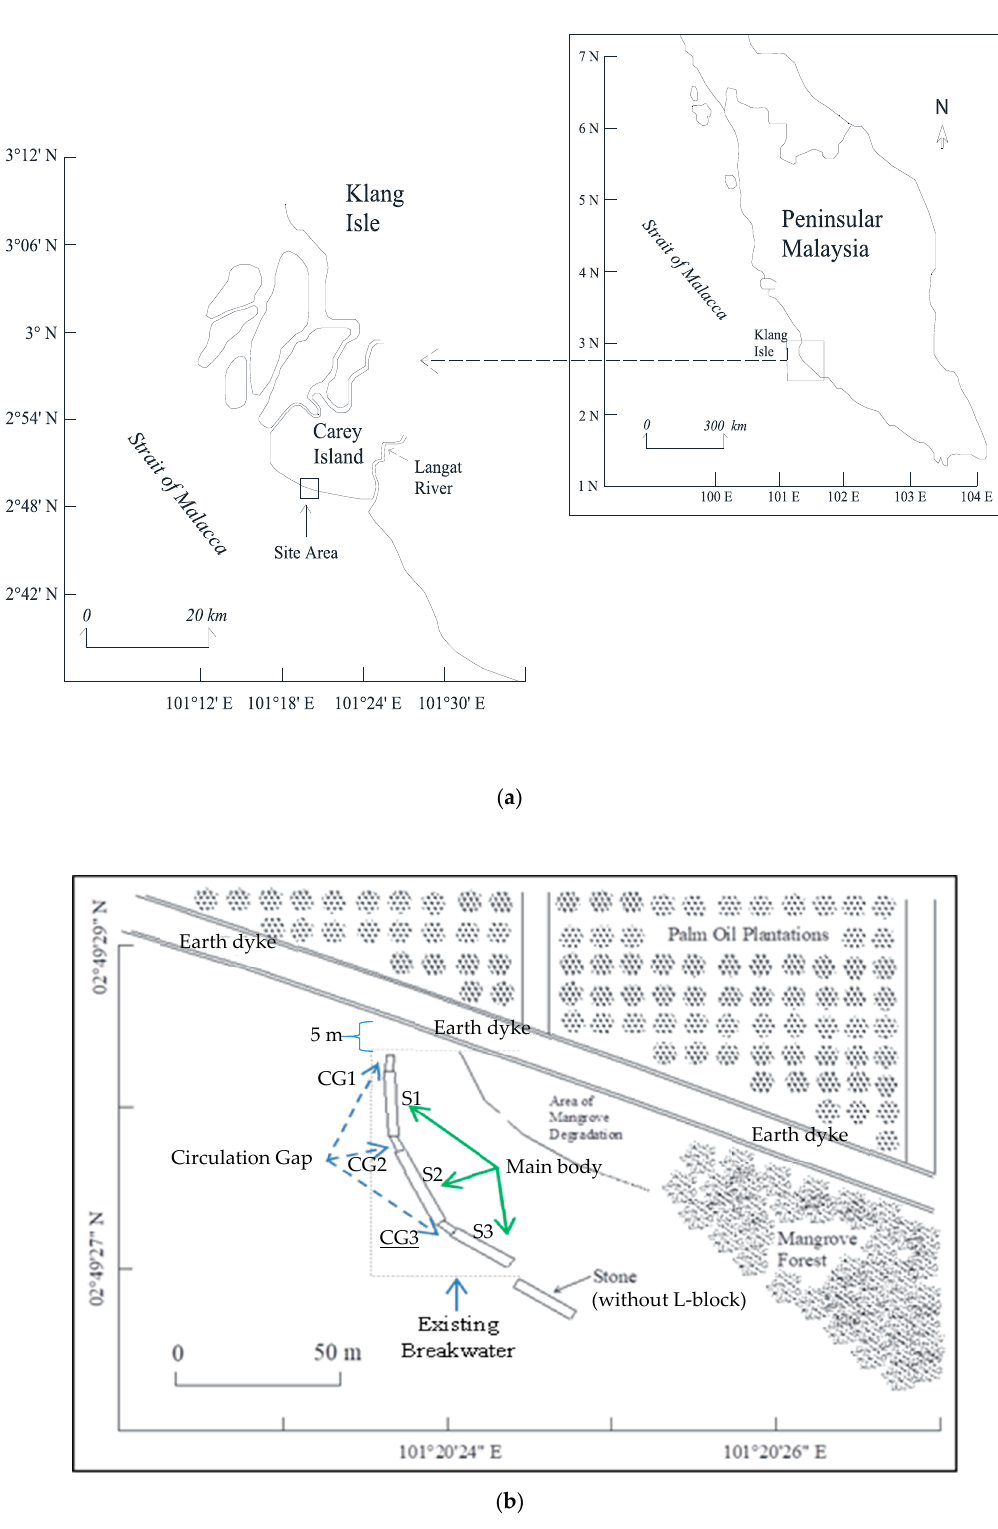
Figure 1. View of the study area: ( a ) location of Carey Island, Malaysia; ( b ) study site.